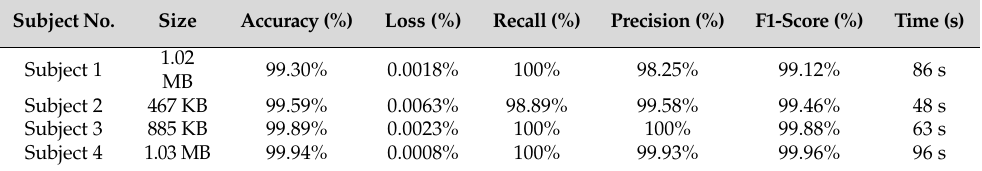
Table 7. Performance evaluation (different datasets with correlated ABPDias with ABPSys sensors).